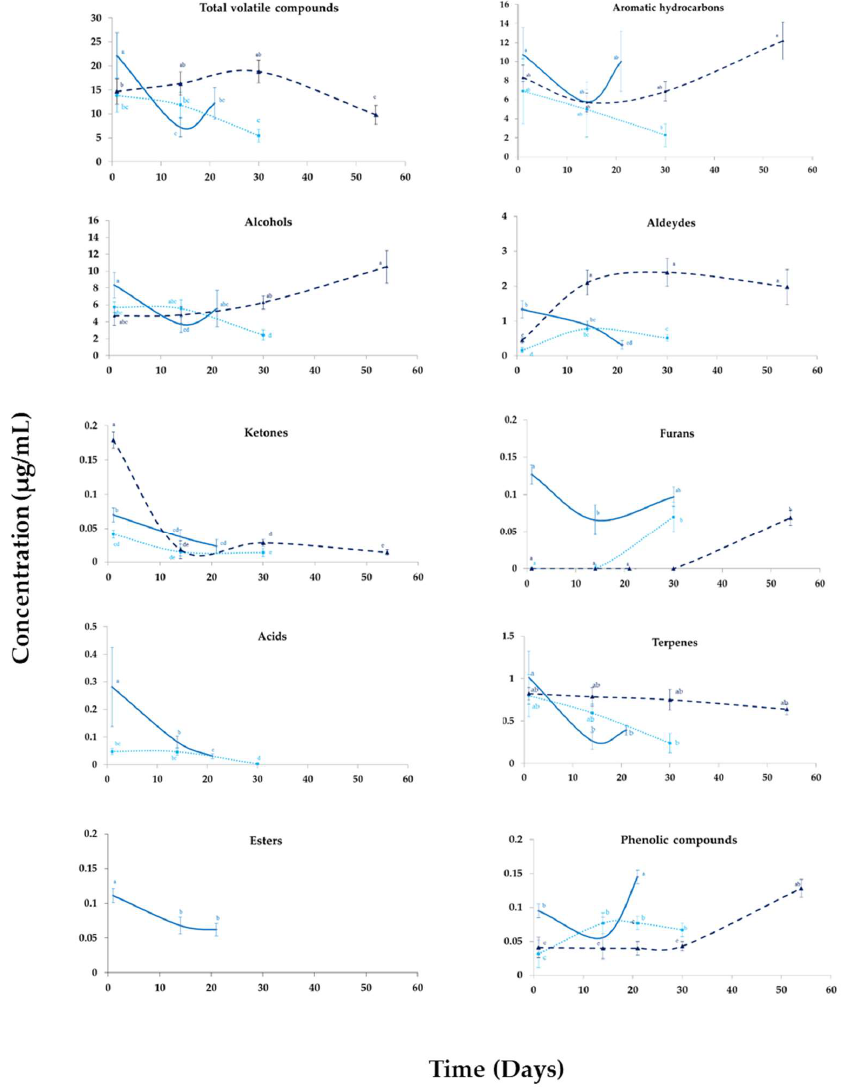
Figure 2. Evolution of volatile compounds in tiger nut beverages during their storage at 4 °C. a–d For each group of family compounds, values with different letters differed significantly ( p < 0.05). H-P: homogenization-pasteurization at 18 + 4 MPa (pressure of first stage valve + second stage valve) at 65, and 80 °C for 15 s (-); 200 MPa: ultra-high pressure homogenization at 200 MPa and Ti = 40 °C (….); 300 MPa: ultra-high pressure homogenization at 300 MPa and Ti = 40 °C (----); Concentration: μg equivalents of 4-methyl-2-pentanol internal standard per mL of tiger nuts’ milk beverage.